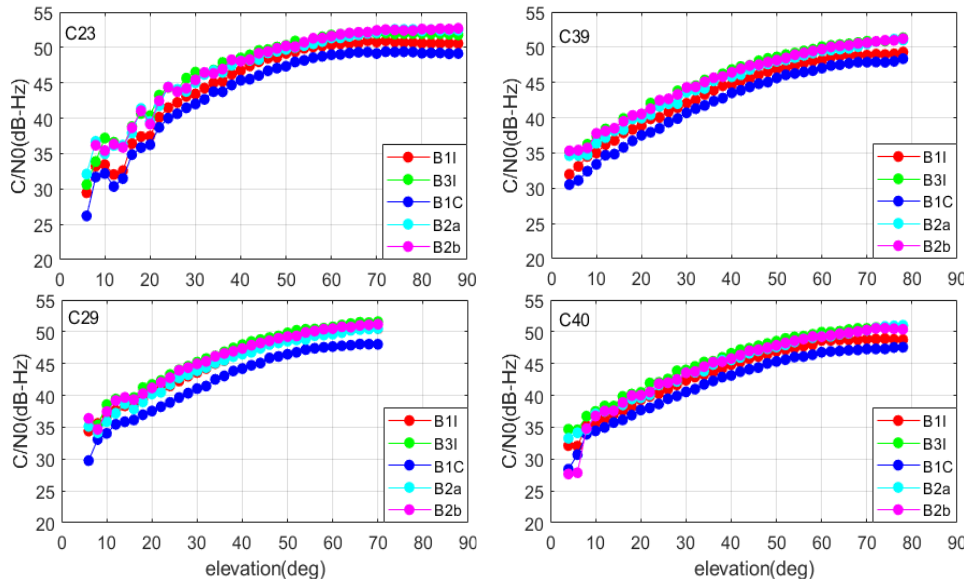
Figure 3. Average C/N0 series of BDS-3 satellites in different frequency.